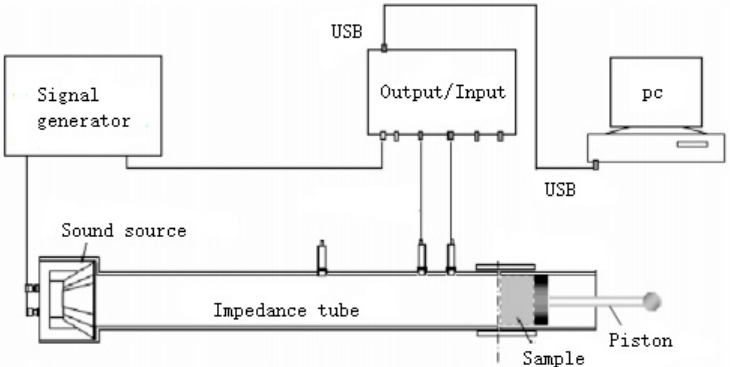
Figure 1. Schematic diagram of the sound-absorption test.